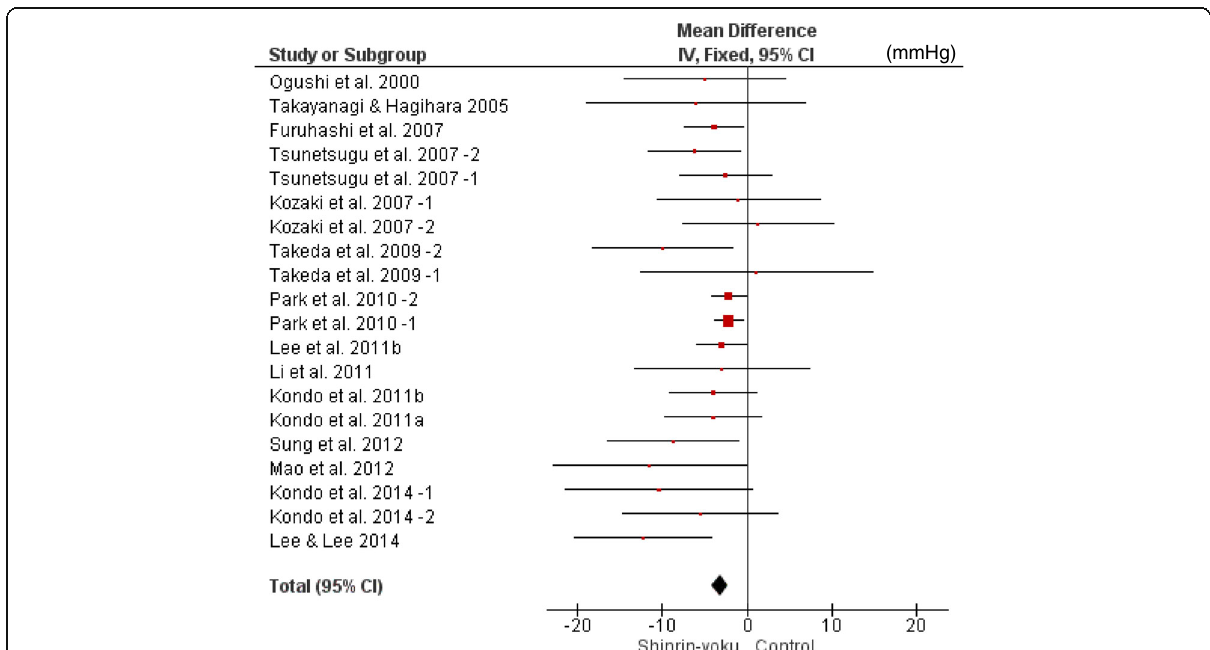
Fig. 2 Forest plot comparing changes in SBP (mmHg) between the forest environment and the non-forest environment based on 20 studies or subgroupsCI, confidence interval.